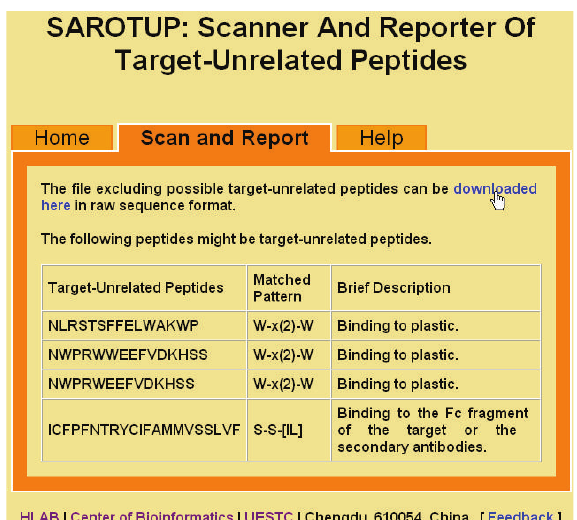
Figure 3: Snapshot of SAROTUP result page. Target-unrelated peptides in the b12 test case are reported in the table. The new panel of peptides excluding the target-unrelated peptides can be downloaded from the